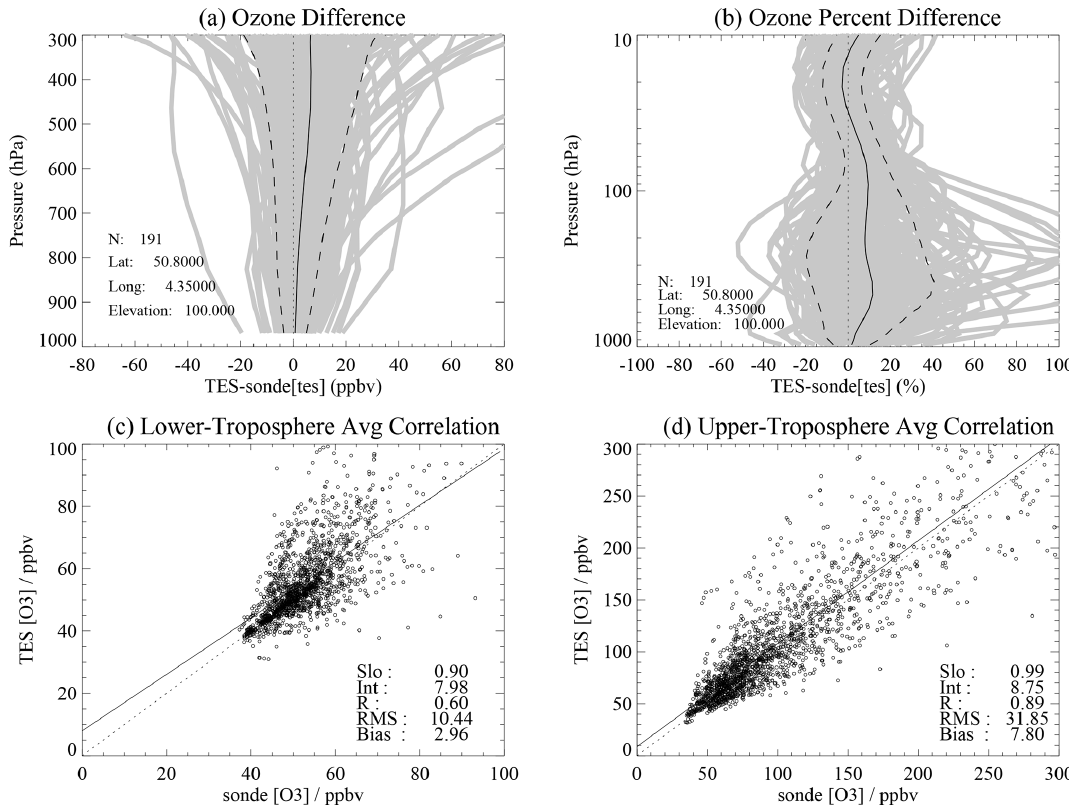
Figure 7. Absolute TES–sonde tropospheric ozone vertical differences (a) and relative differences (b) for the whole profile of Uccle. Indi- vidual difference profiles are shown in grey; the mean difference and 1 standard deviation profiles are shown in black. N is the number of valid profiles after flagging TES data and using the maximum 300km and 9h coinciding criteria. Panel (c) illustrates the correlation between TES and sonde O 3 for the lower troposphere (1000 to 500hPa), including the slope (Slo), intercept (Int), and correlation ( R ) of the linear regression; the root mean square error (RMS); and the bias. Panel (d) is the same as panel (c) but for the upper troposphere (500hPa to the